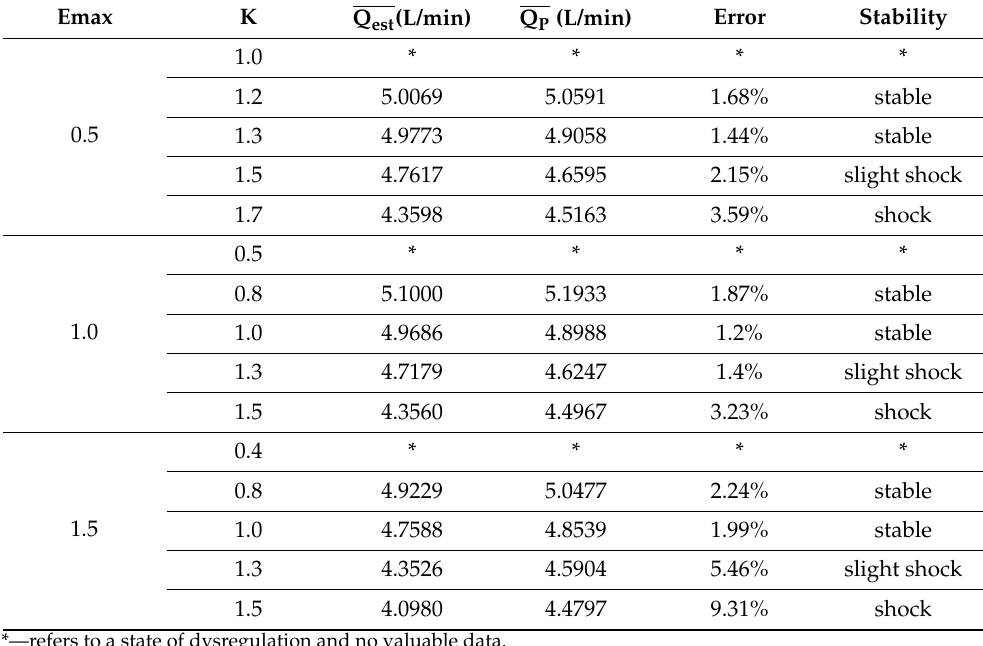
Table 3. Comparison of controller sensitivity under different degrees of heart failure.